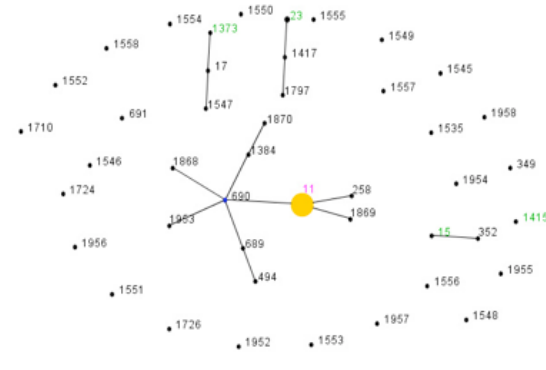
Figure 1: The cluster analysis full view diagram of 38 CRKP strains comparing with ST classification of Klebsiella pneumoniae in Zheji- ang province. The blue circle denotes the primary founder. The yellow circle denotes the subgroup founder. The pink number denotes the ST type exists in both experimental strains and strains in Zhejiang province. The green numbers denote the ST type only exists in the experimental strains, and black numbers are the ST types of Kleb- siella pneumoniae exist in Zhejiang